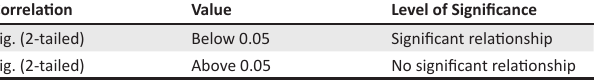
TABLE 3: Sig. (2-tailed) declaration.